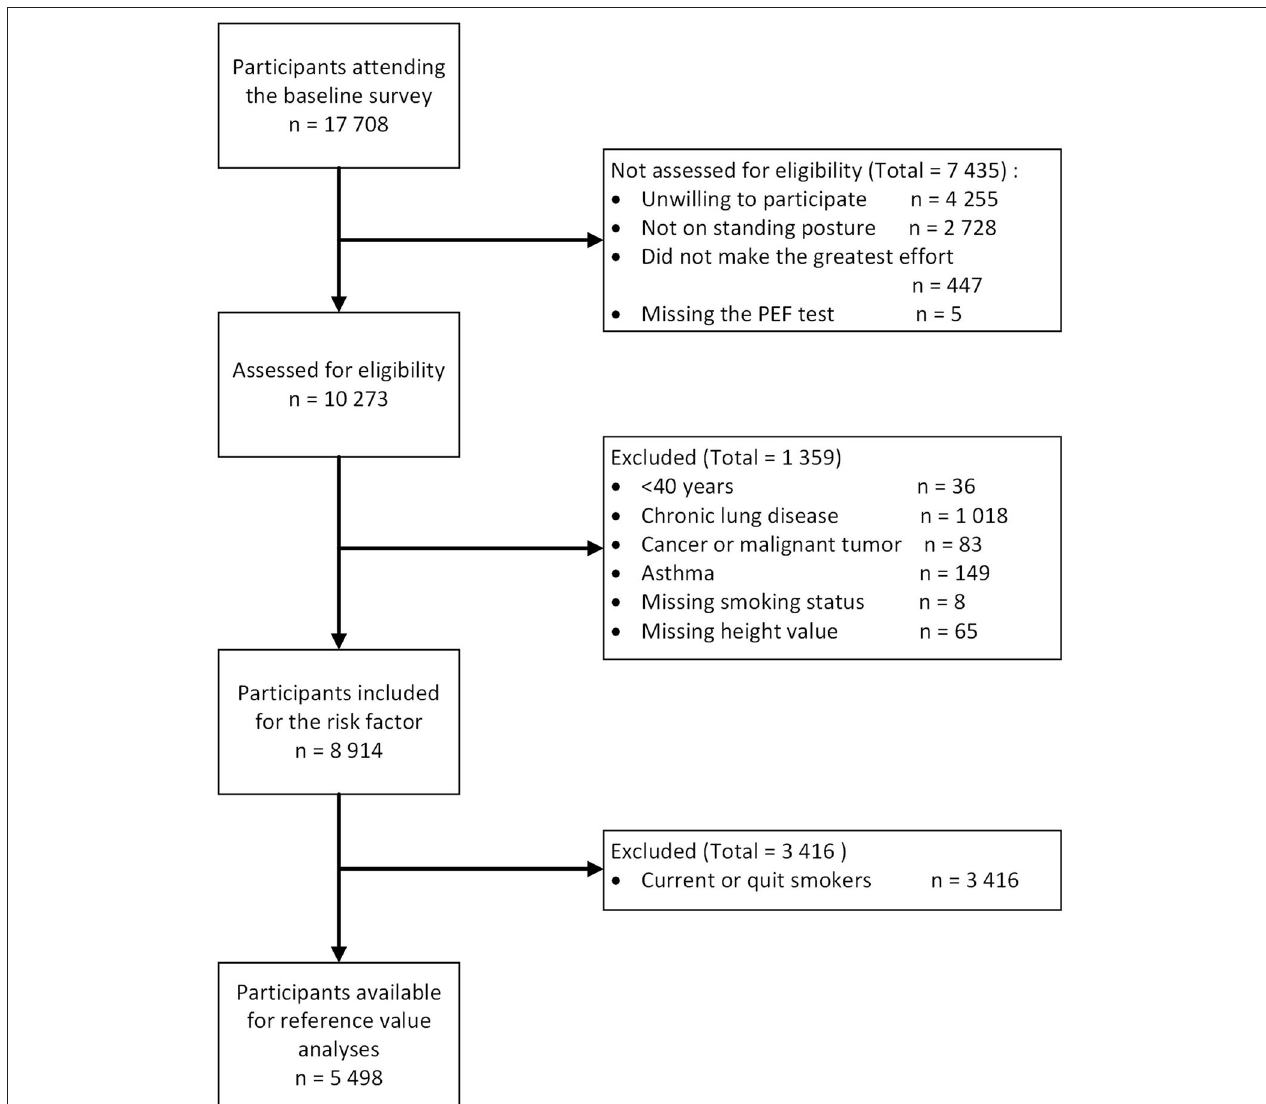
FIGURE 1 | The flow chart of the peak expiratory flow (PEF)